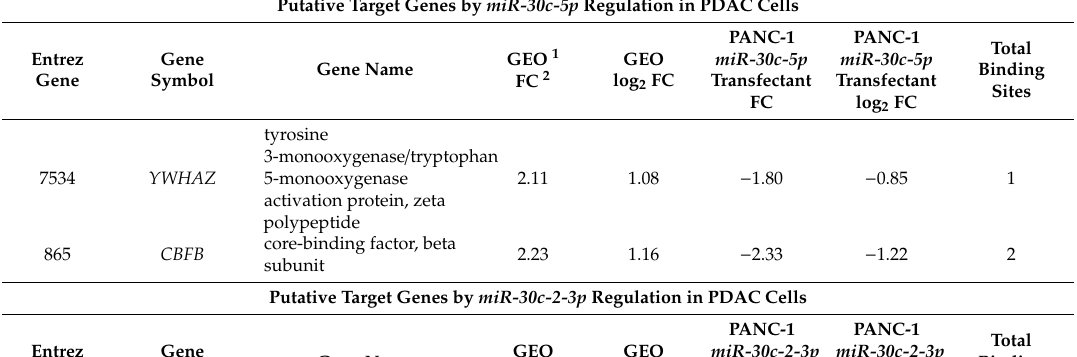
Table 1. Putative target genes by miR-30c-5p and miR-30c-2-3p regulation in PDAC cells. Putative Target Genes by miR-30c-5p Regulation in PDAC